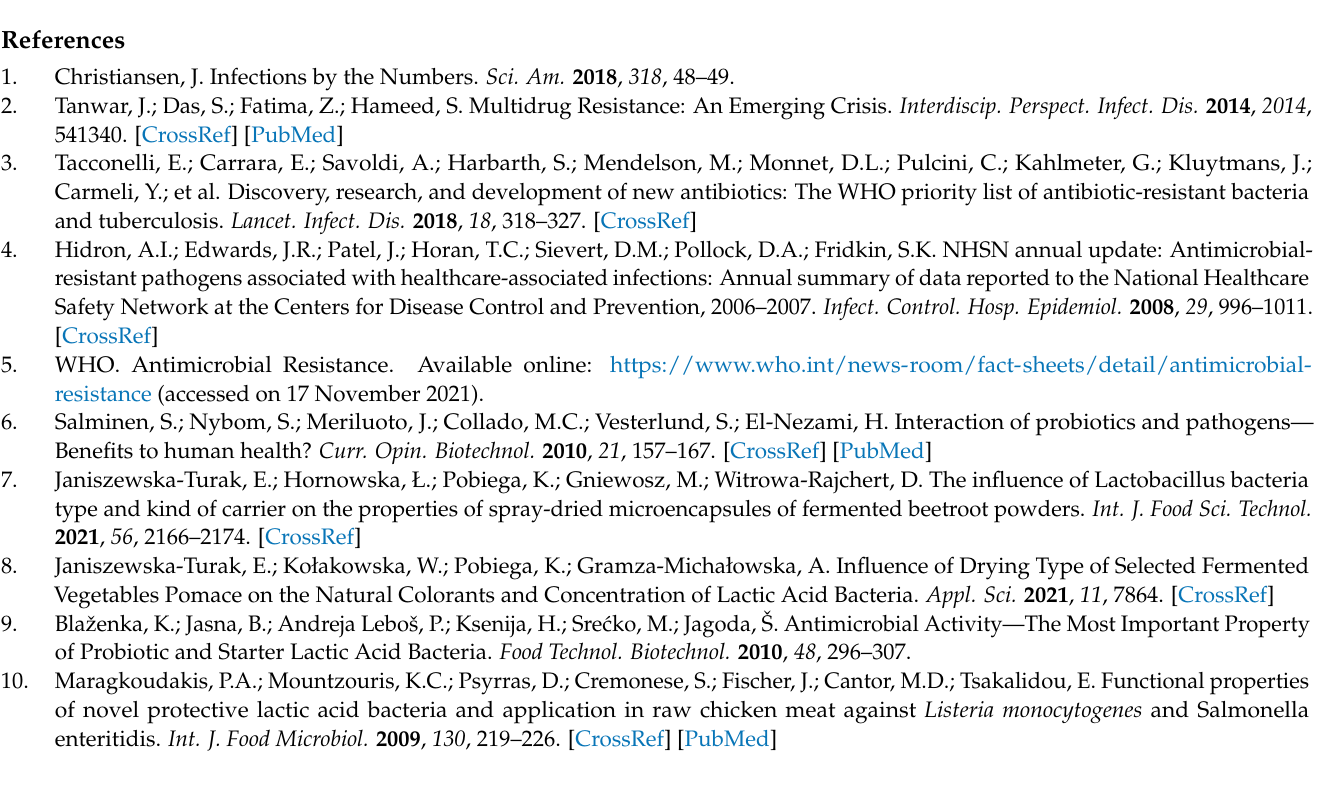
Table S1: Physiochemical features of identified isolates RWP-3 and RWP-7, Table S2: Different carbohydrate substrates fermentation by RWP-3 and RWP-7, Table S3: Production of extra cellular enzyme by RWP-3 and